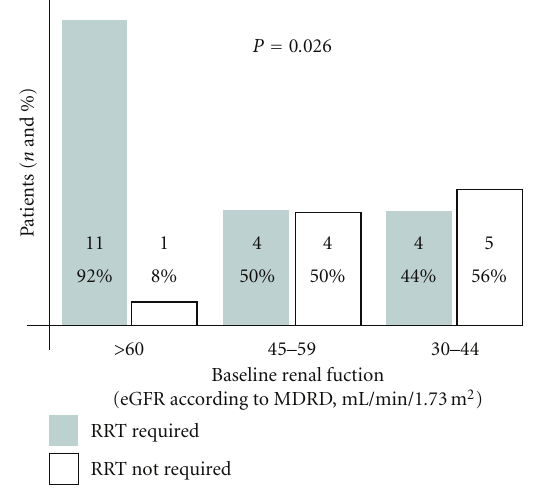
Figure 1: Influence of previous renal function on renal replacement therapy requirement during the acute kidney injury episode. Number and percentage of patients that required renal replacement therapies in relation with previous renal function. ∗ Previous renal function expressed as estimated glomerular filtration rate in mL/min/1.73m 2 calculated according to the MDRD-4-IMDS